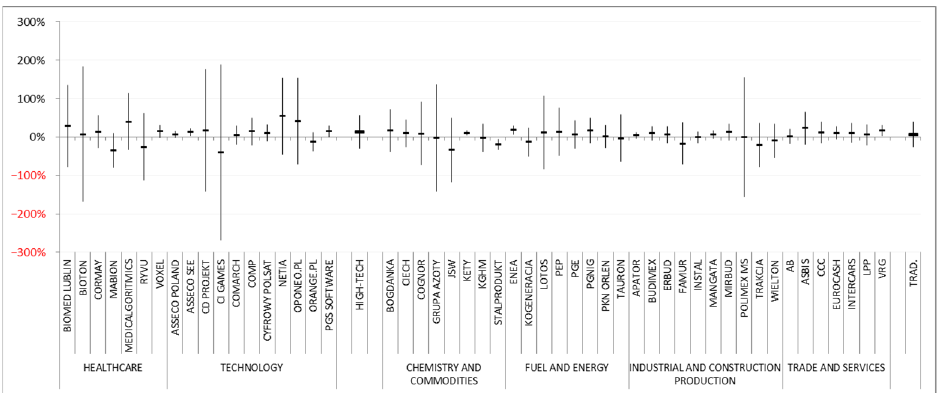
Figure 2. Assessment of changes in the result on sales in the surveyed enterprises. Source: own work.